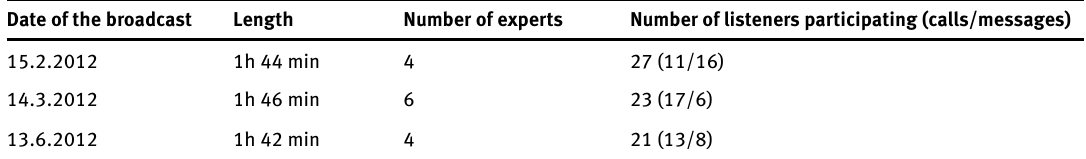
Table 1. The Luontoilta broadcasts studied Date of the